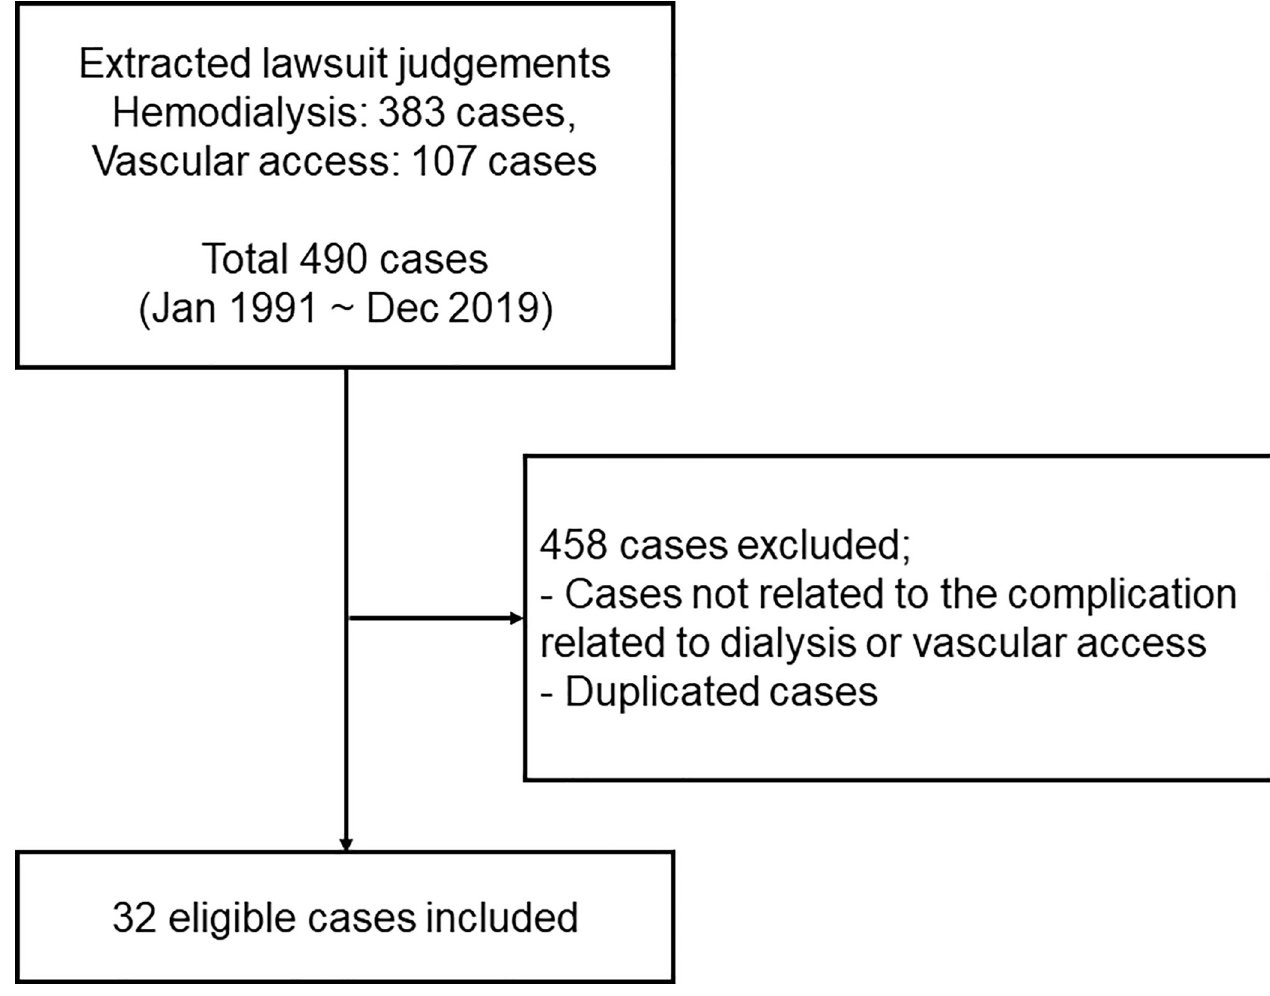
Fig 1. Flowchart of judgement selection based on the inclusion and exclusion